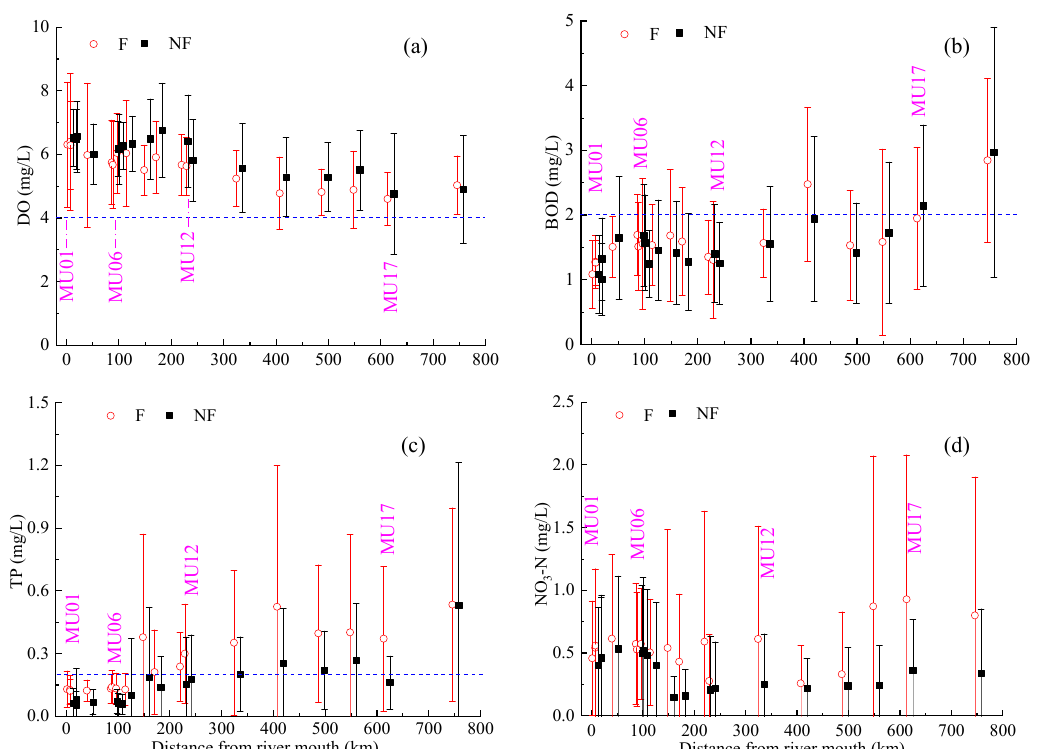
Figure 4. Spatial variation of mean concentrations of typical parameters DO ( a ), BOD ( b ), TP ( c ), and NO 3 -N ( d ) during flood (F) and non-flood (NF) season along the Mun River. The dash blue lines mark the threshold concentration of parameters corresponding to class III of surface water quality standard in Thailand, no line for NO 3 -N since its concentration at all sites lower than threshold value.